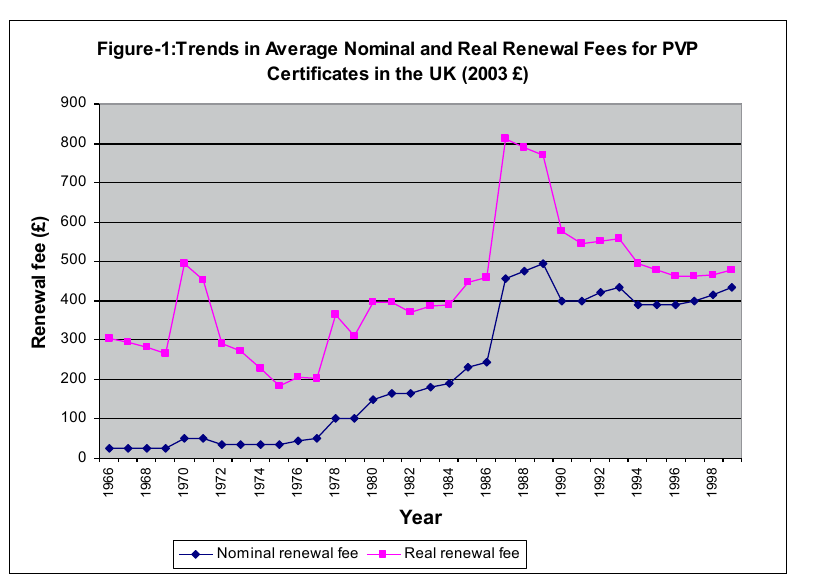
Table 1. Data for survival analysis by Crop Group (Cohort range 1965-2000)